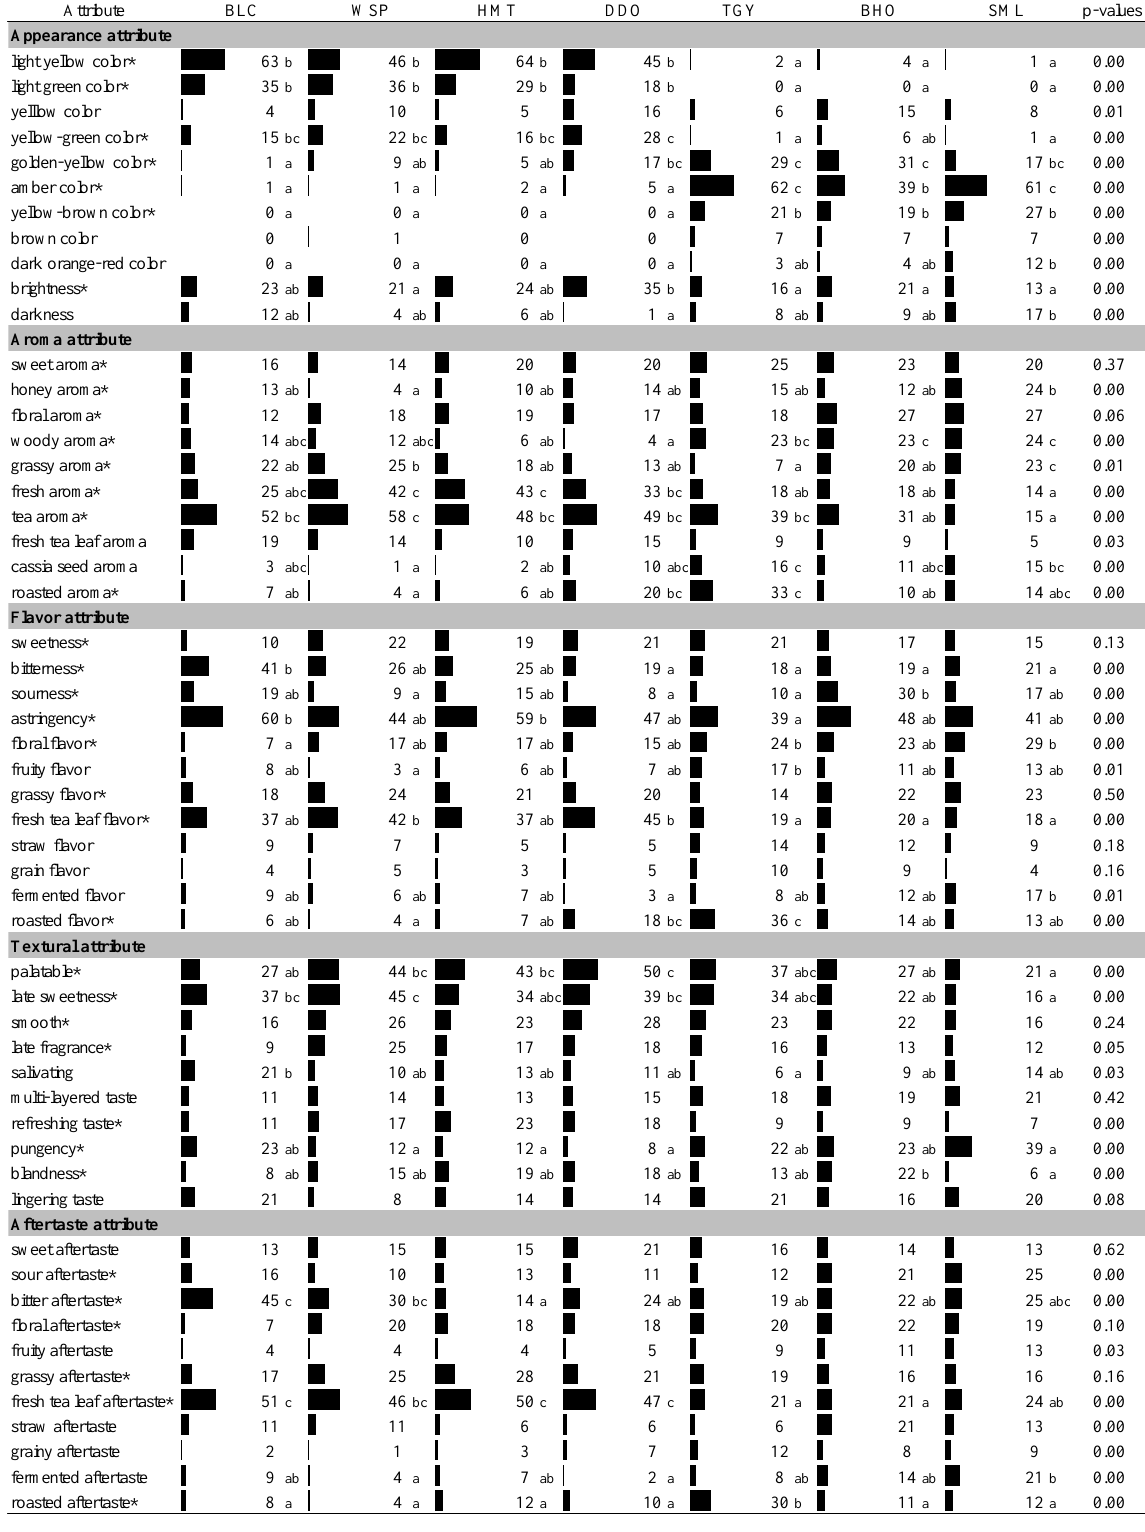
Figure 1. Selection frequencies of 54 sensory attributes for the cold-brewed infusions originated from seven Taiwanese specialty teas based on the check-all-that-apply (CATA) method ( n = 108). BLC: Bi-Lo-Chung, WSP: Wenshen Paochong tea, HMT: High-mountain tea, DDO: Dong Ding Oolong tea; TGY: Tie-Guan-Yin, BHO: Baihao Oolong tea, SML: Sun-Moon-Lake black tea. Asterisks are marked on the attributes are significant at p < 0.05